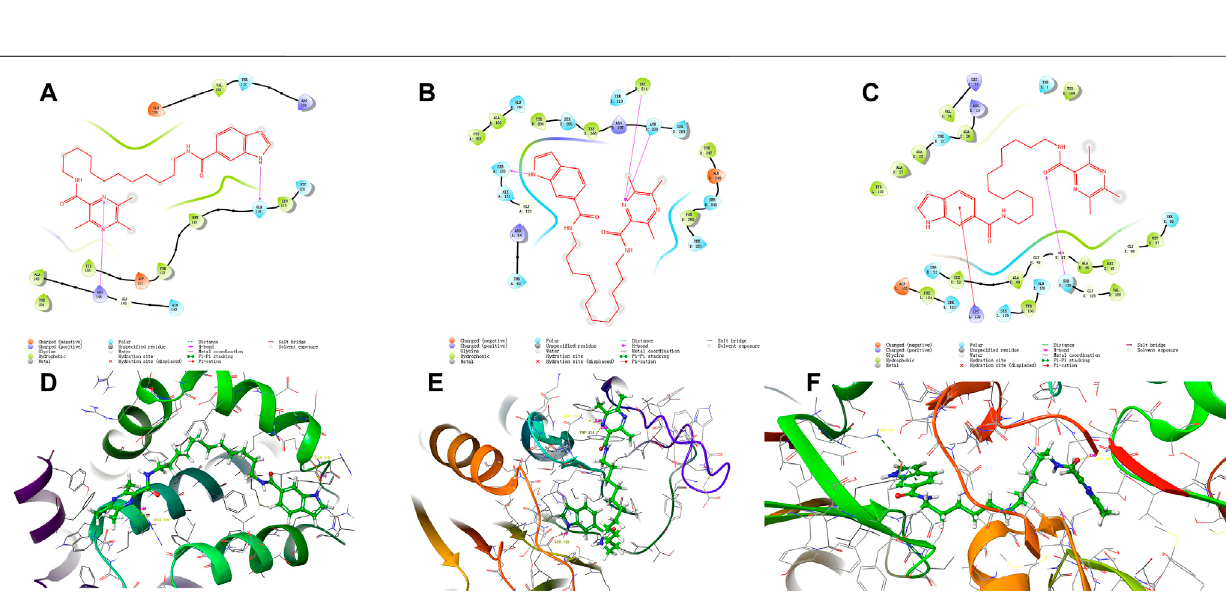
Frontiers in Chemistry |